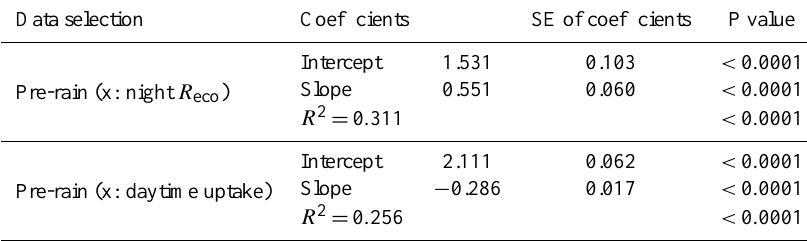
Table 5. Statistics of linear regressions between R sg and NEE (see Fig.